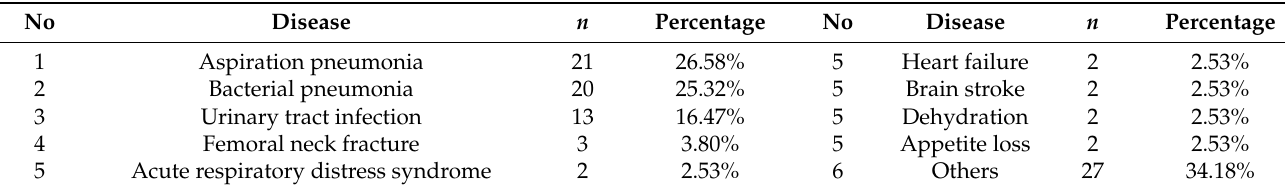
Table 3. Diseases as reasons for patient